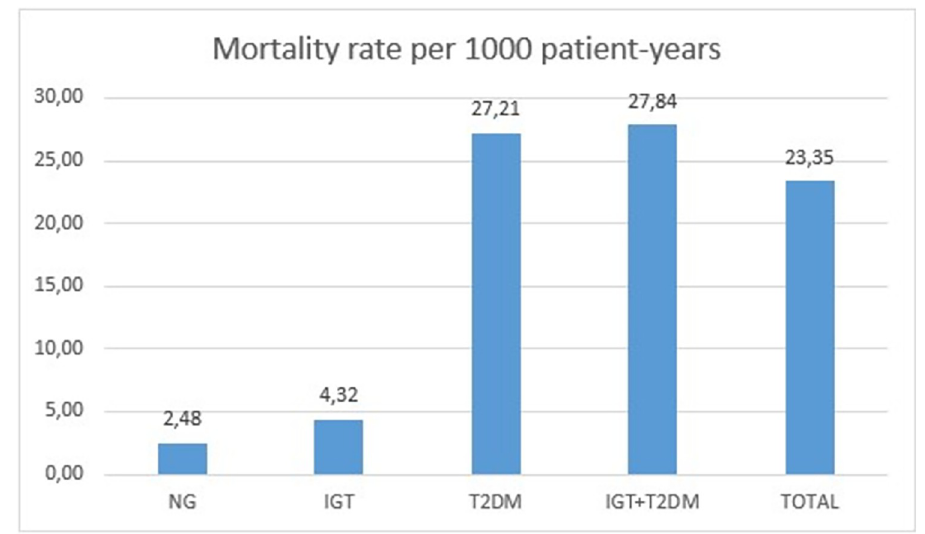
Fig 2. Mortality rates according to glycemic status. NG: normoglycemia; IGT: impaired glucose tolerance; T2DM: type 2 diabetes mellitus.